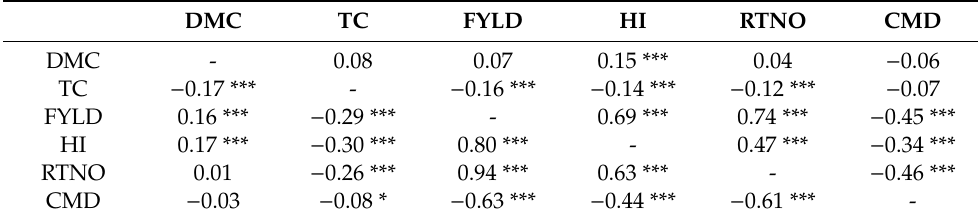
Table 8. Estimates of phenotypic (upper diagonal) and genetic (lower diagonal) correlations for characteristics evaluated in 21 cassava